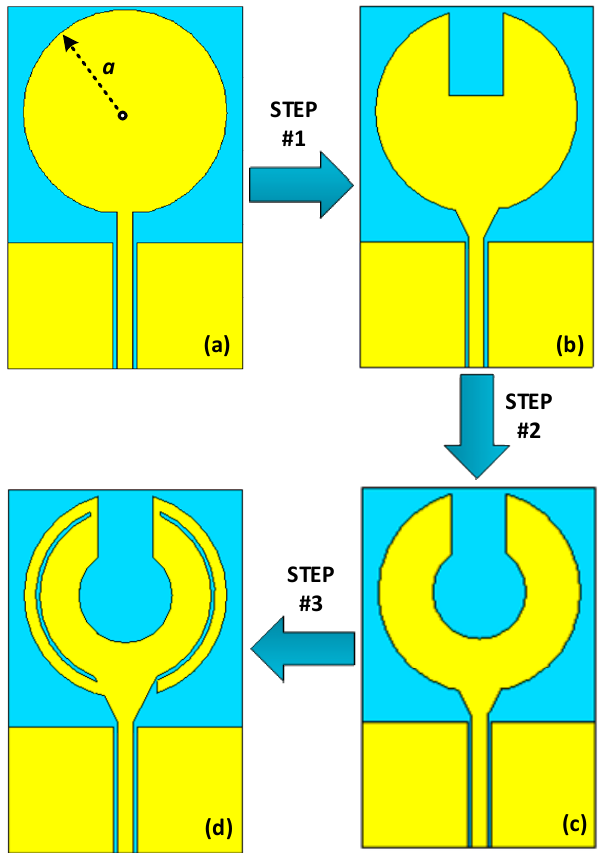
Figure 2. Design procedure of the proposed MIMO antenna unit cell, ( a ) Standard circular antenna with a coplanar waveguide feedline, ( b ) circular patch antenna with cutout rectangular section and widened edge feed point, ( c ) circular patch in step #1 with circular section cutout, and ( d ) Circular patch in step #2 with embedded curved slot lines on both sides of the patch however the slot line on the right-hand side is cut to create a curved open-circuited stub.